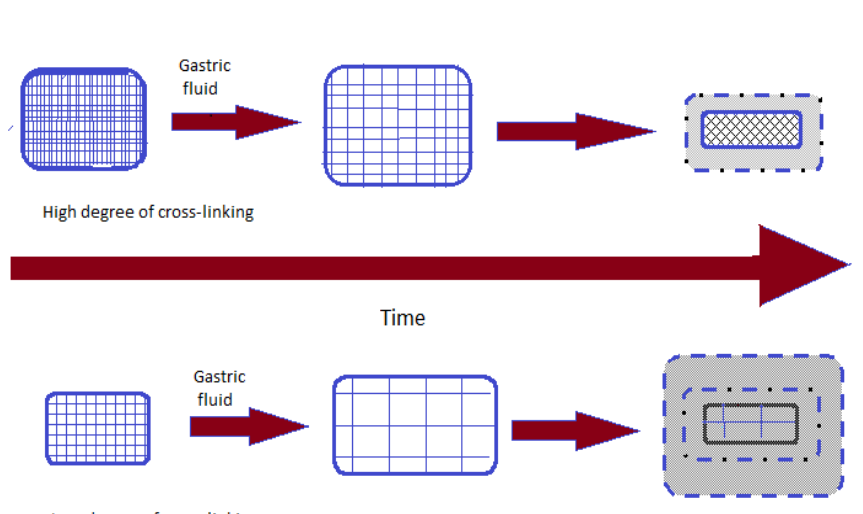
Fig. 4. Relationship between the degree of cross-linking of the polymeric chains and the swelling behaviour of swelling system